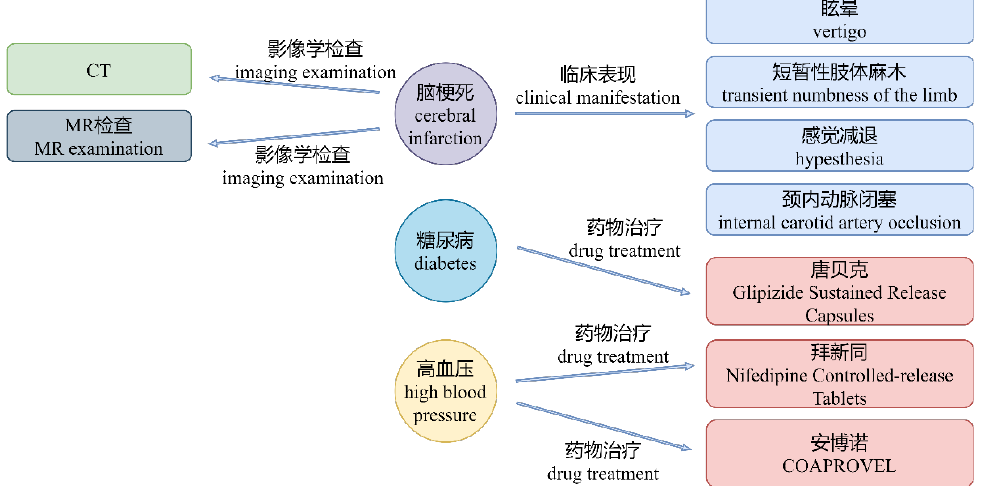
Figure 3. The results of the RC task in original data.